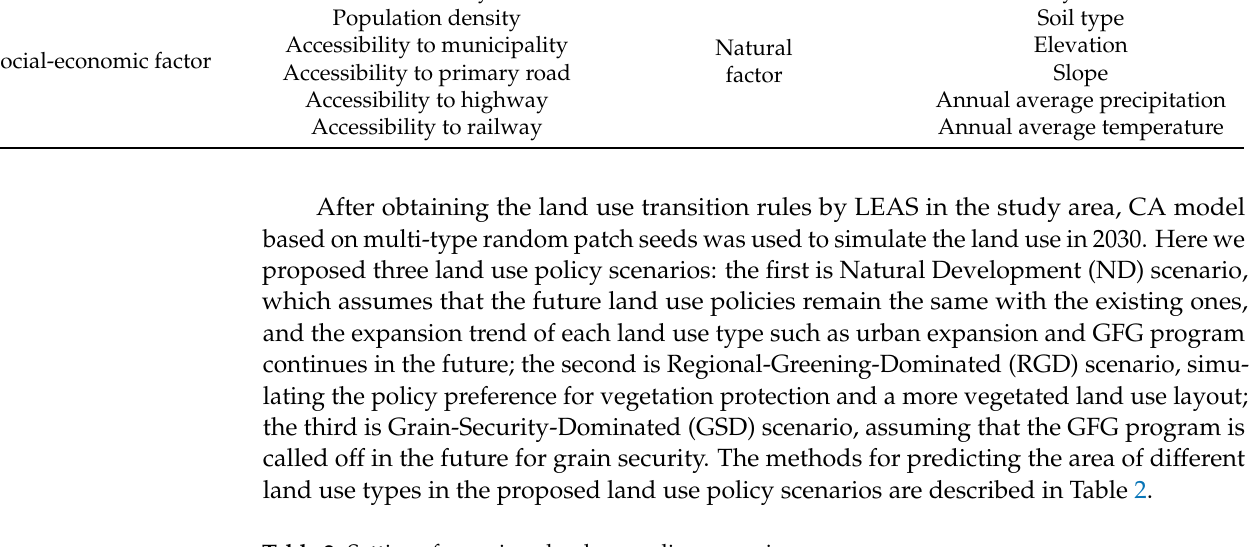
Table 2. Settings for various land use policy